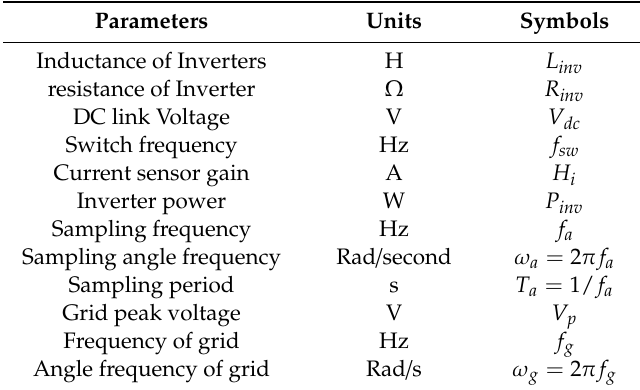
Table 4. Parameter of the system